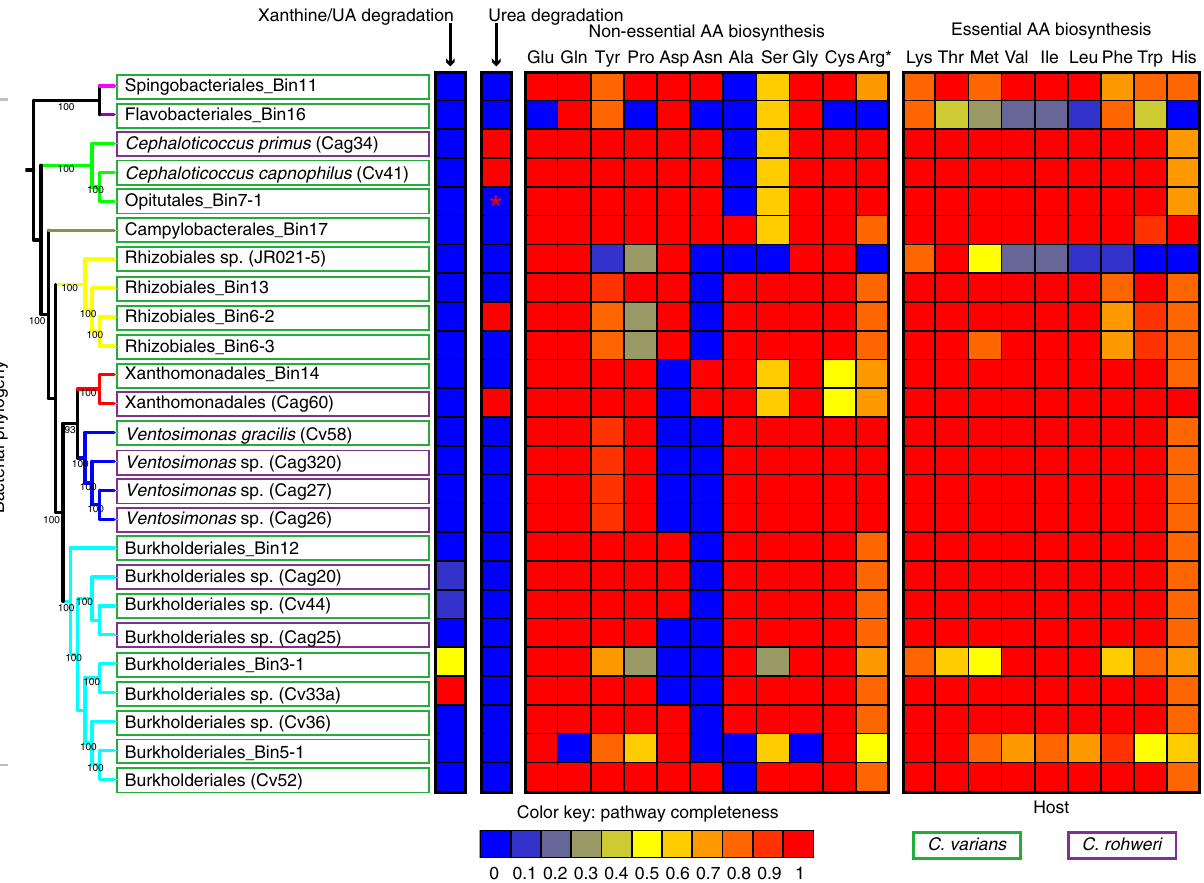
Fig. 5 Core symbiont strains possess complete or near complete pathways for N-recycling and amino acid biosynthesis. Heatmap illustrates the proportion of genes present from each N-metabolic pathway across distinct symbiont strains. Coding capacities for strains were inferred from 14 fully sequenced cultured isolate genomes (symbionts from C. varians and C. rohweri ) and 11 draft genomes (assembled from C. varians colony PL010 metagenome; identi fi ed by the term “ Bin ” within their names). The maximum likelihood phylogeny of symbiotic bacteria on the left was inferred using an alignment of amino acids encoded by seven phylogenetic marker genes obtained from symbiont genomes, and branch colors are used to illustrate distinct bacterial orders. Red asterisk for urea recycling in the Cephaloticoccus -like Opitutales bin (7-1) indicates that urease genes from the PL010 metagenome binned to Opitutales, but not to the draft genome for the dominant strain. When combined with the likely presence of just one Opitutales strain within the PL010 microbiome (see Results), it is likely that a completely assembled genome would encode all urease genes. Black asterisk for arginine indicates that we examined the completeness of arginine biosynthesis based on the pathway with glutamate as a